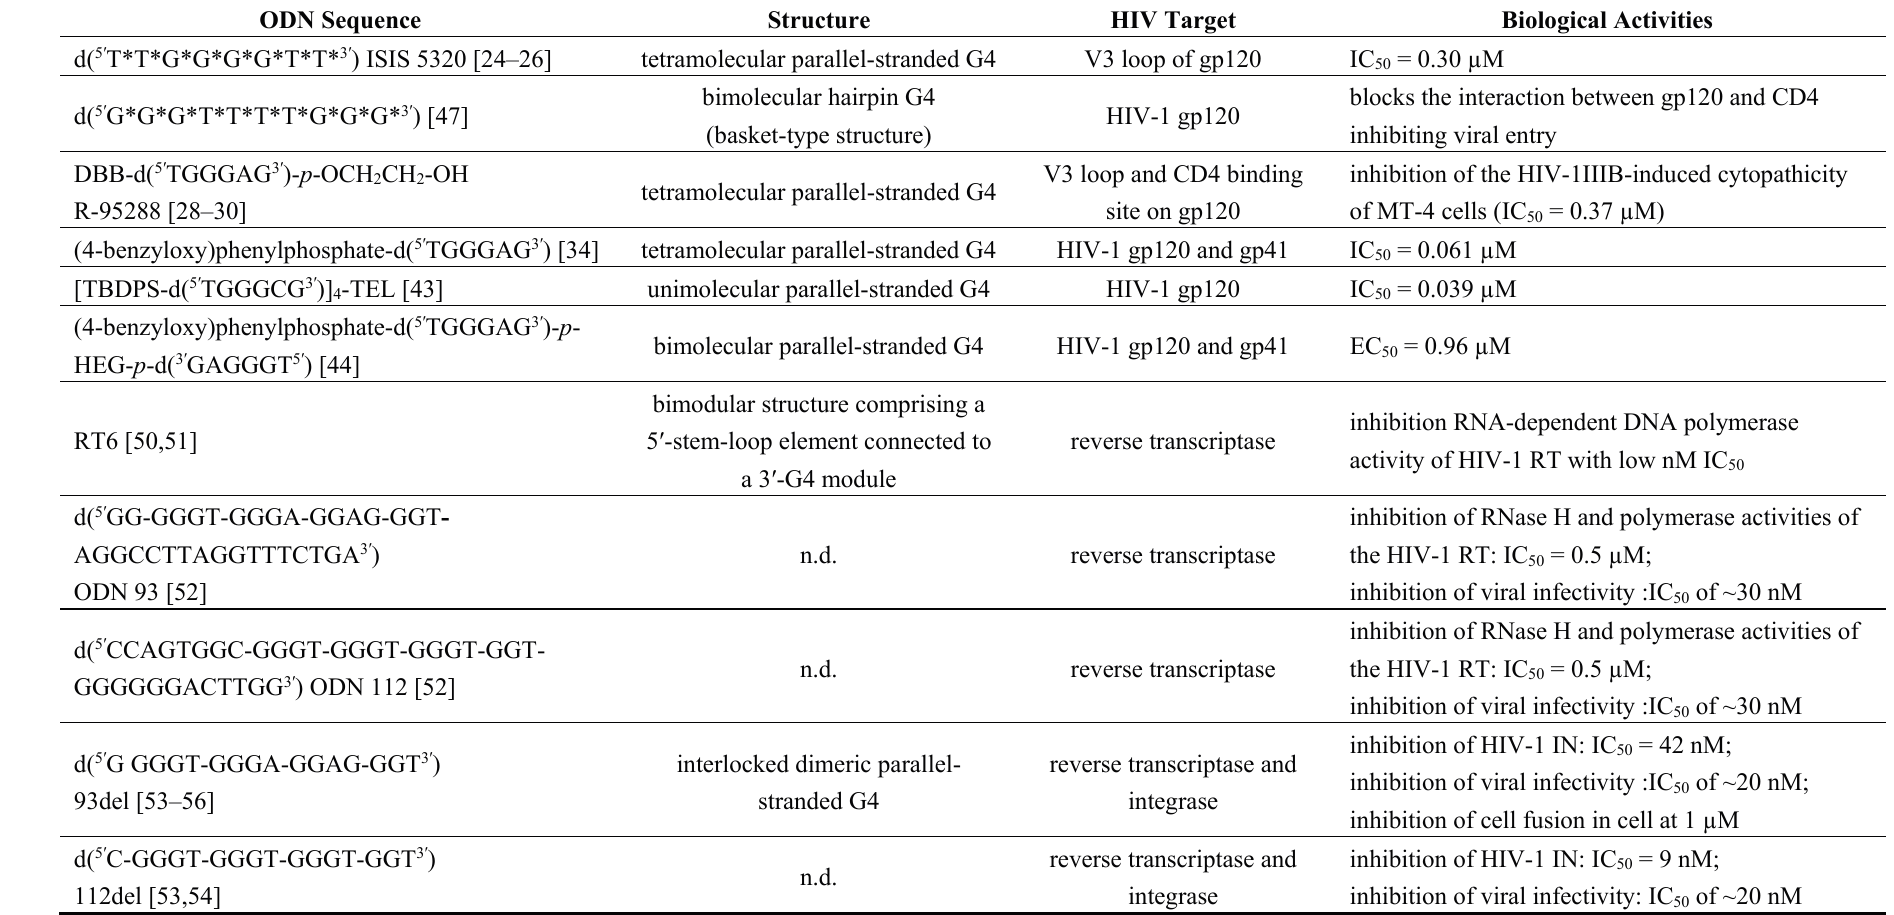
Table 1. Summary data on the G4-forming oligonucleotides exhibiting anti-HIV activity discussed